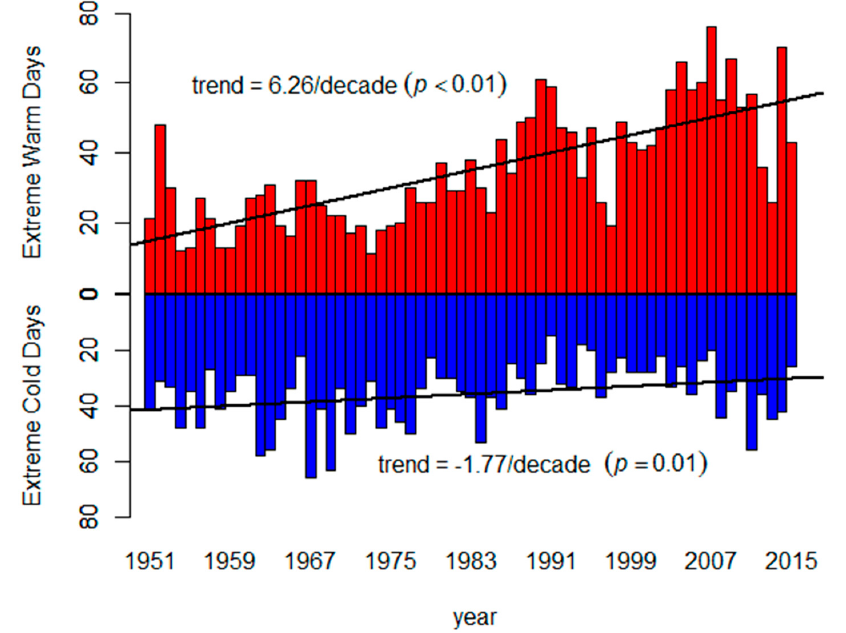
Figure 2. The number of extreme warm/cold days in Guangzhou over 1951–2015. The black lines indicate the linear trend.